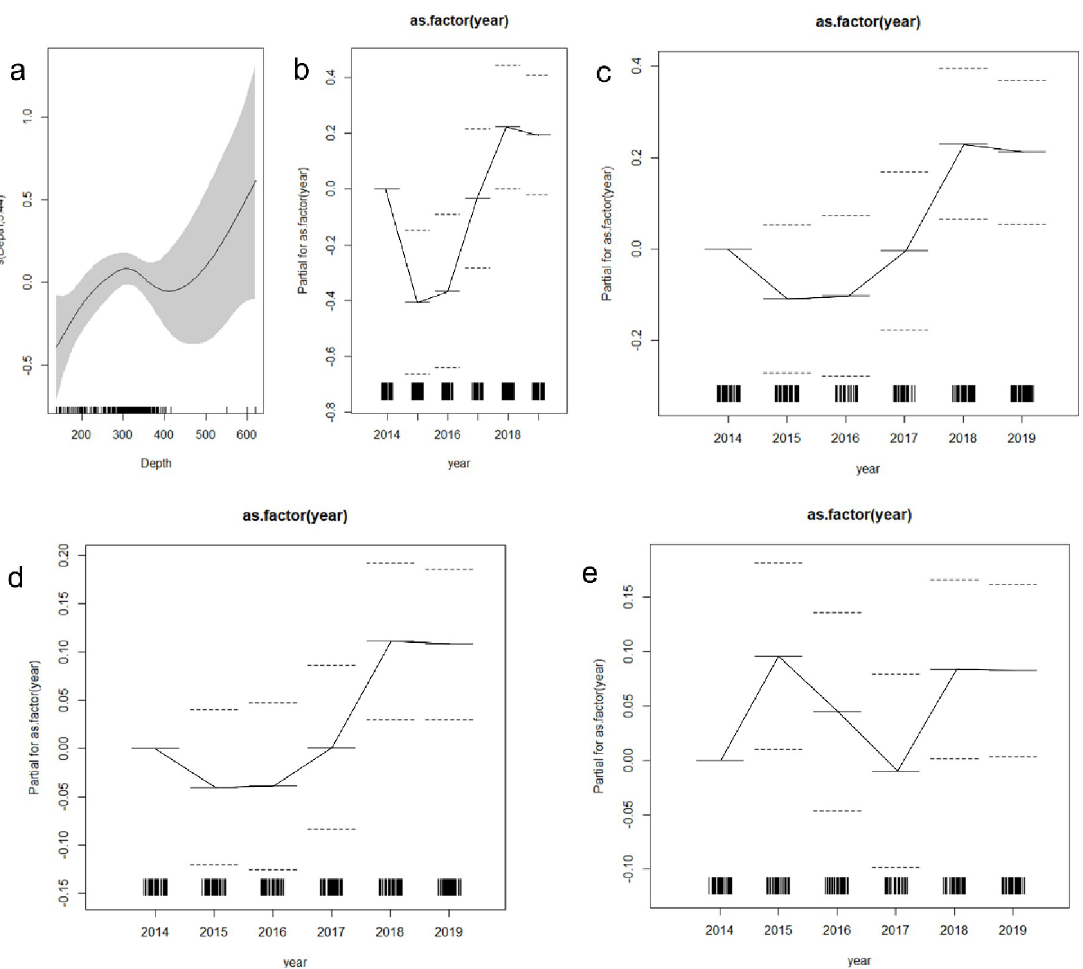
Fig 11. Effects of the predictors Depth and Year on richness (a and b, respectively), fitted for a GAM model. Effects of predictor Year on the Shannon-Weiner diversity index (c), Simpson index (d) and Pielou’s evenness (e). Straight lines represent the mean and dotted lines represent the confidence interval